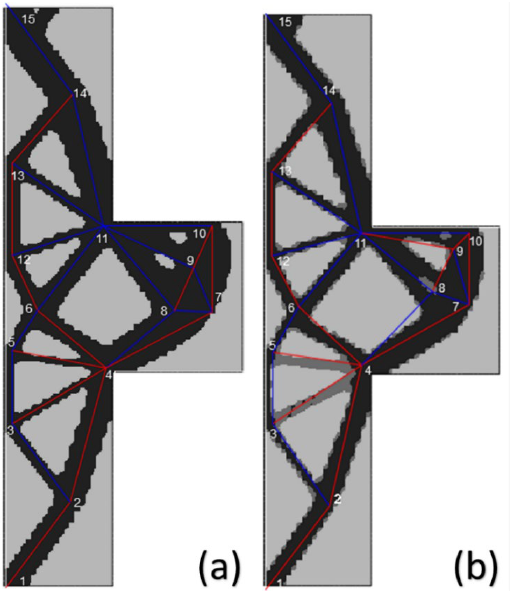
Figure 10. Suggested truss models for the rectangular corbel a) f = 50%; b) f =